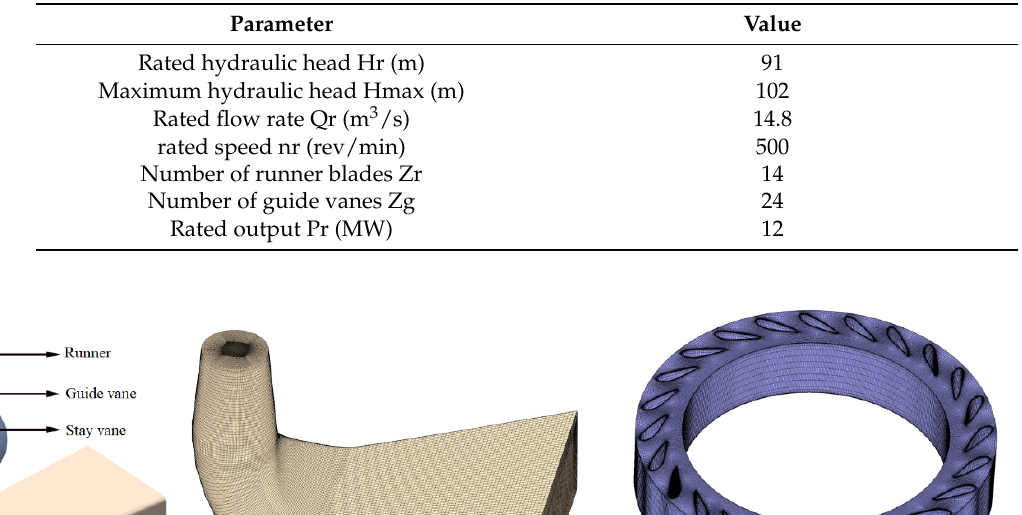
Table 1. Basic geometric parameters of Francis turbine.